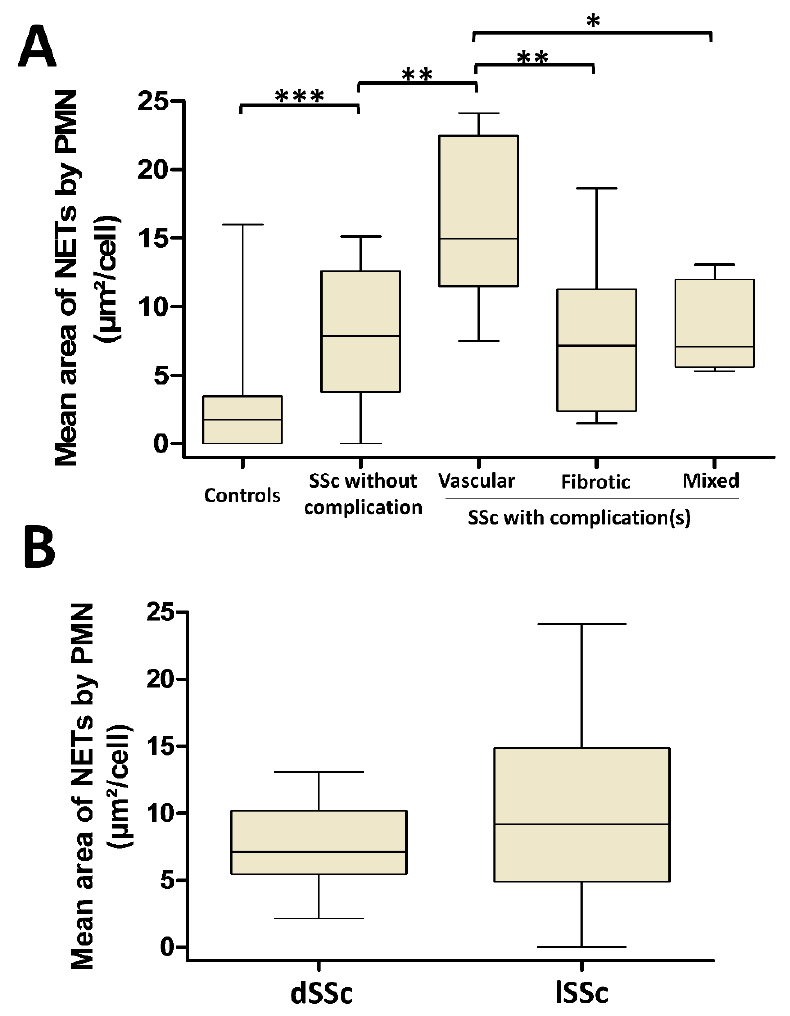
Figure 4. NETosis is increased in SSc patients with vascular complications and is not dependent on the extension of skin fibrosis. ( A ) PMN from SSc patients and controls were stimulated in autologous conditions. Patients were grouped according to their type of complications (vascular, fibrotic, or mixed complications) or the absence of complications. Pulmonary arterial hypertension, digital ulcers, and scleroderma renal crisis were considered as vascular complications, di ff use phenotype and interstitial lung disease were considered as fibrotic complications, and mixed complications were defined as the association of at least one vascular and one fibrotic complication. All conditions (n = 26 for controls, n = 12 for patients without complication, n = 8 for SSc with vascular complications, n = 9 for SSc with fibrotic complications, and n = 5 for SSc with mixed complications) were performed in duplicate. ( B ) Patients were grouped according to their skin phenotype (di ff use SSc (dSSc) or limited SSc (lSSc)) and PMN were stimulated in autologous conditions. All conditions (n = 8 for dSSc, and n = 26 for lSSc) were performed in duplicate. The mean area of NETs released by PMN is represented by a “box and whiskers” plot for each condition tested. Boxes show the 25–75th percentiles, lines show the median value, and whiskers show the range of the mean area of NETs released by PMN. *** p < 0.001, ** p < 0.01, * p <